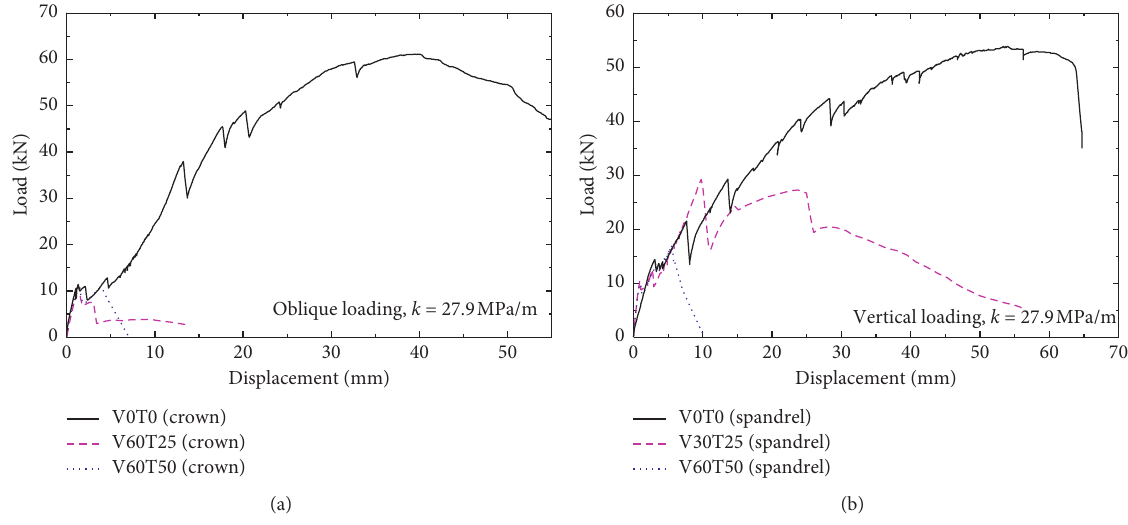
Figure 13: Load-displacement curves of the lining with combined defects: (a) crown and (b)